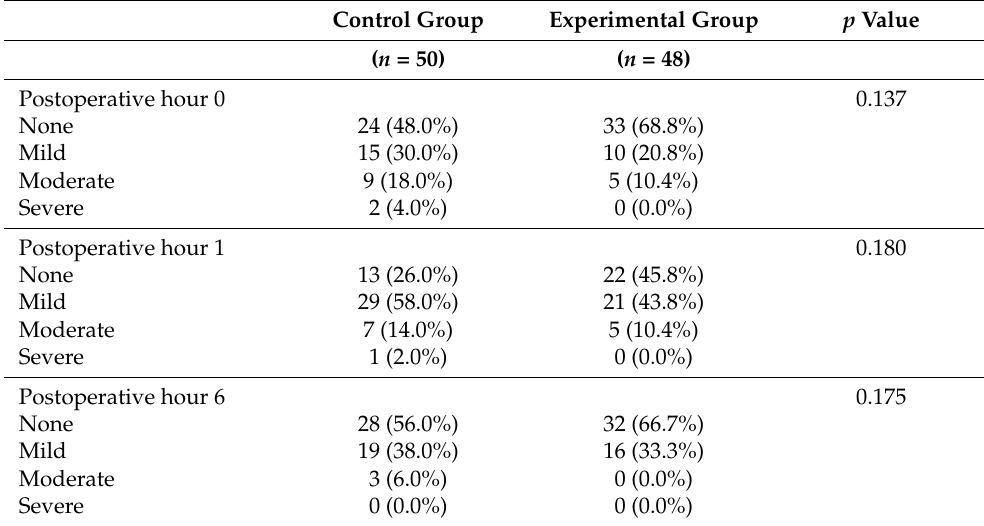
Table 3. Comparison of the grade of catheter-related bladder discomfort after surgery between the control and experimental groups.